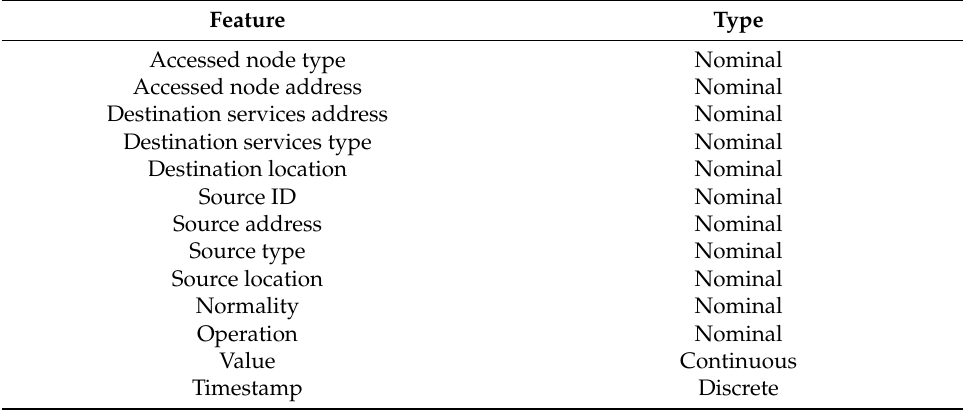
Table 2. DS2OS dataset features.